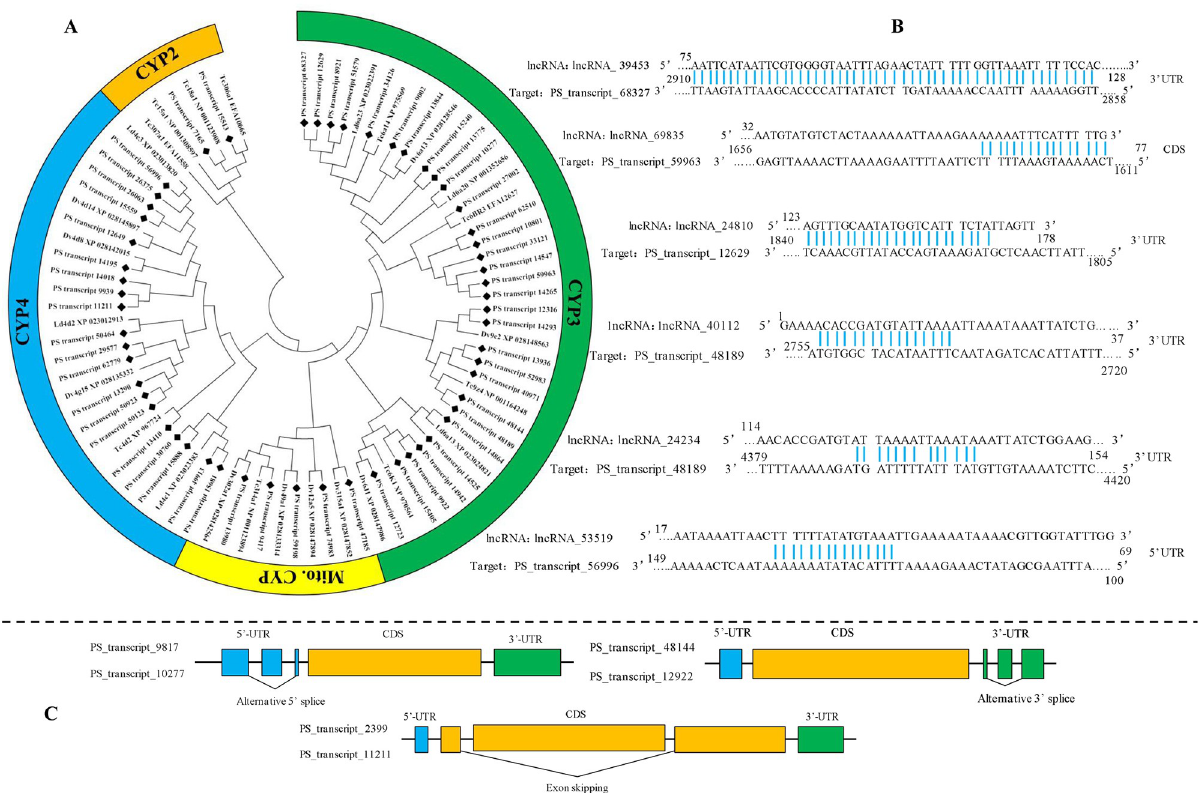
Fig 2. Sequence analysis, regulatory lncRNA, and splicing events of P450s. A. Phylogenetic analysis of transcripts encoding P450s; B. binding sites of lncRNA and P450s; C. splicing events of P450s.